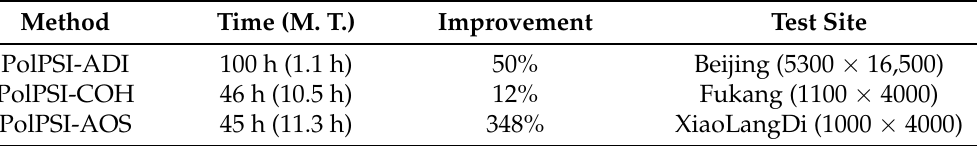
Table 5. Polarimetric optimization computation time of PolPSI